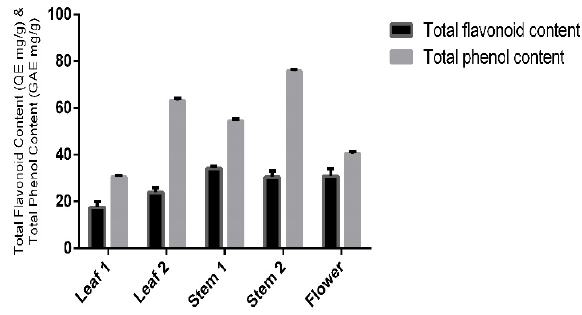
Figure 3: Total phenol and flavonoid content of M. sativa L. extracts at different growing period.